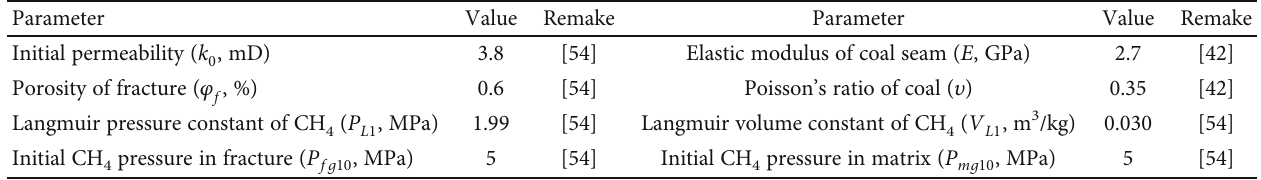
Table 2: Key parameters for model validation.